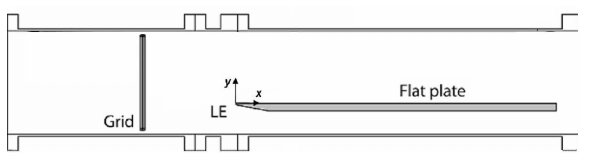
Fig. 2 . Experimental setup - flat plate without diffusser part in the windtunnel test section.